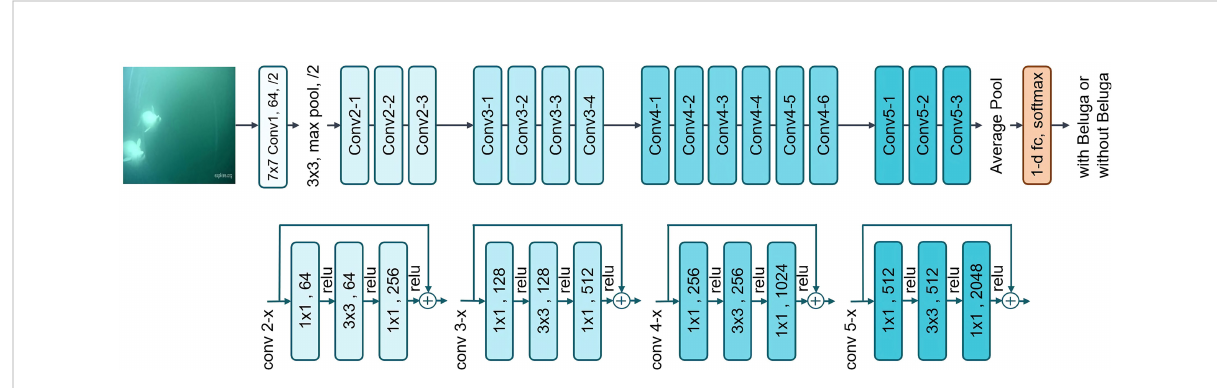
FIGURE 4 Schematic of a ResNet-50 architecture with skip connections, adding the input of each convolution block to its